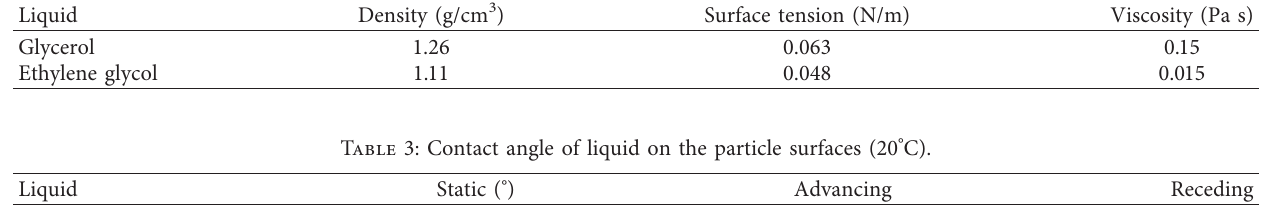
Table 2: Physical and mechanical parameters of glycerol and ethylene glycol (20 ° C).